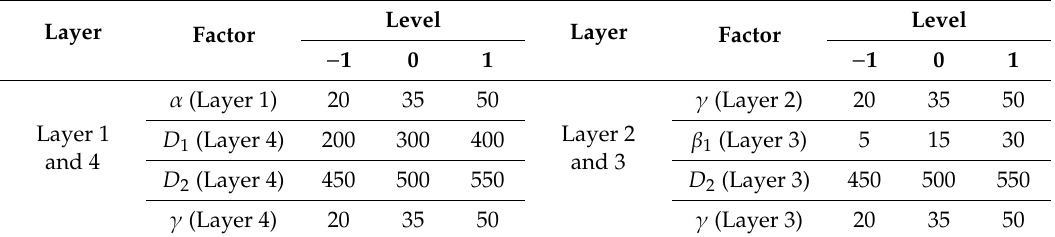
Figure 9. Main effect plot of the airfoil parameters: ( a ) Layers 1 and 4; ( b ) Layers 2 and 3. Table 2. Factors and levels.